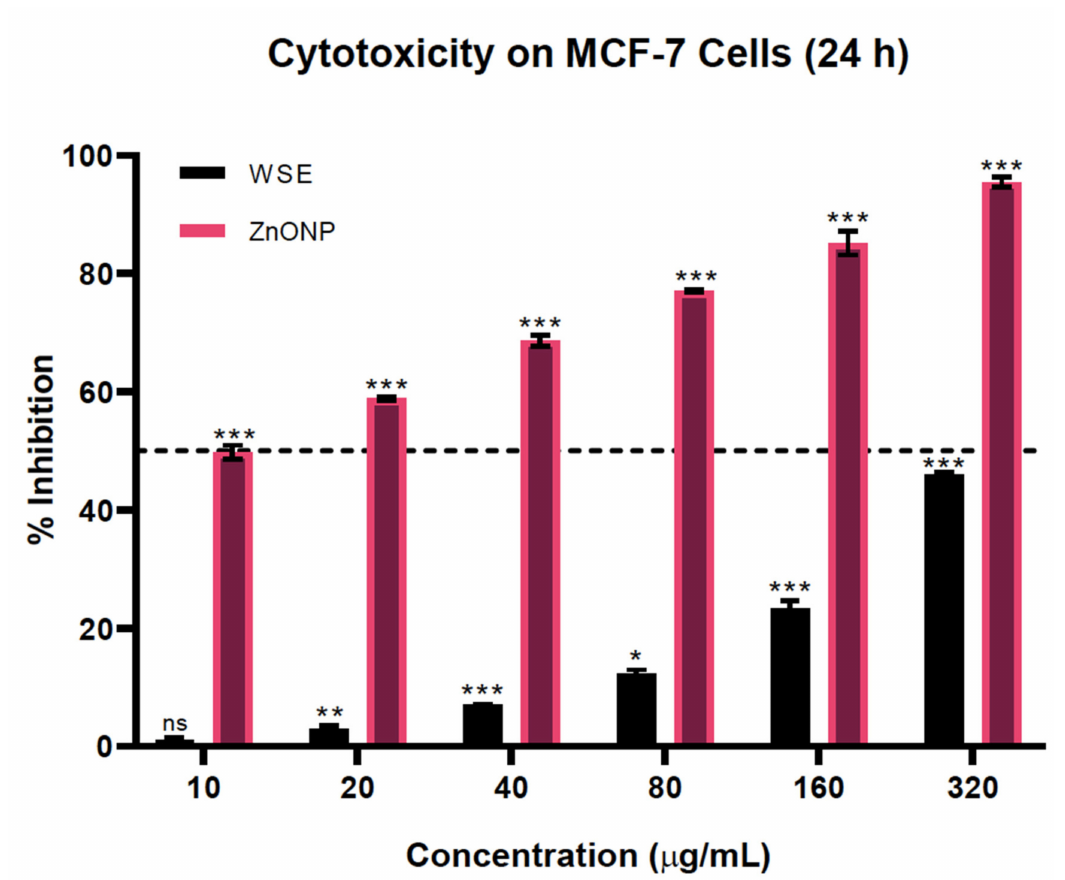
Figure 10. Cytotoxicity of CAE and ZnONPs on breast cancer MCF-7 cells. Results are reported as mean ± SEM for n = 3, and a p - value of < 0.05 was considered to be significant; *p = < 0.033, **p = < 0.002, ***p = < 0.001, ns = not